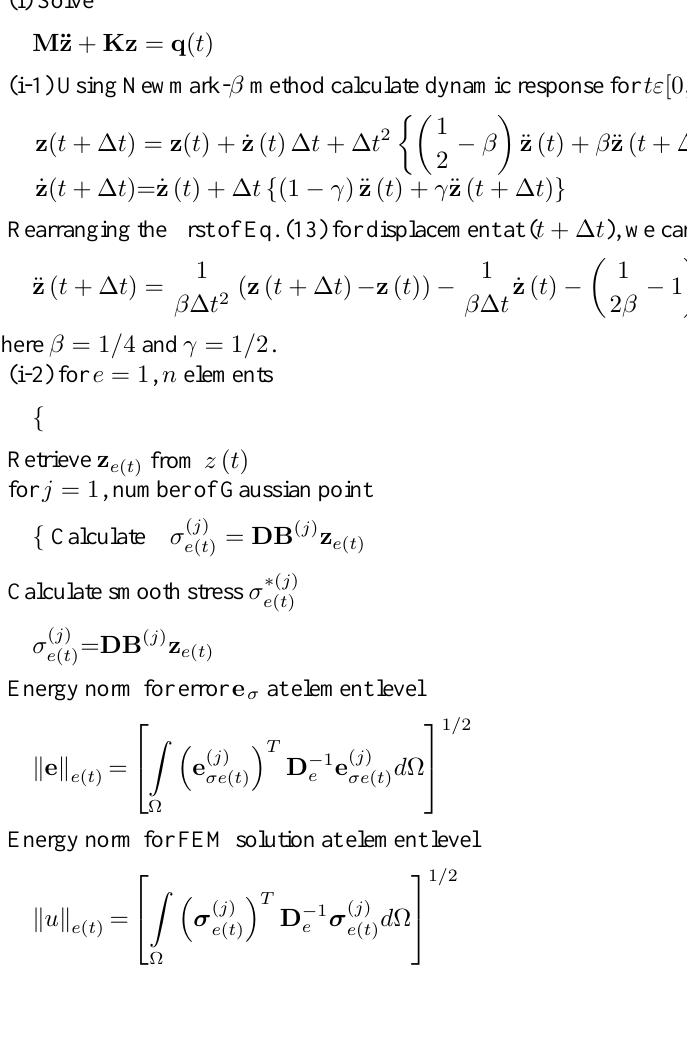
Algorithm for Domain Discretization